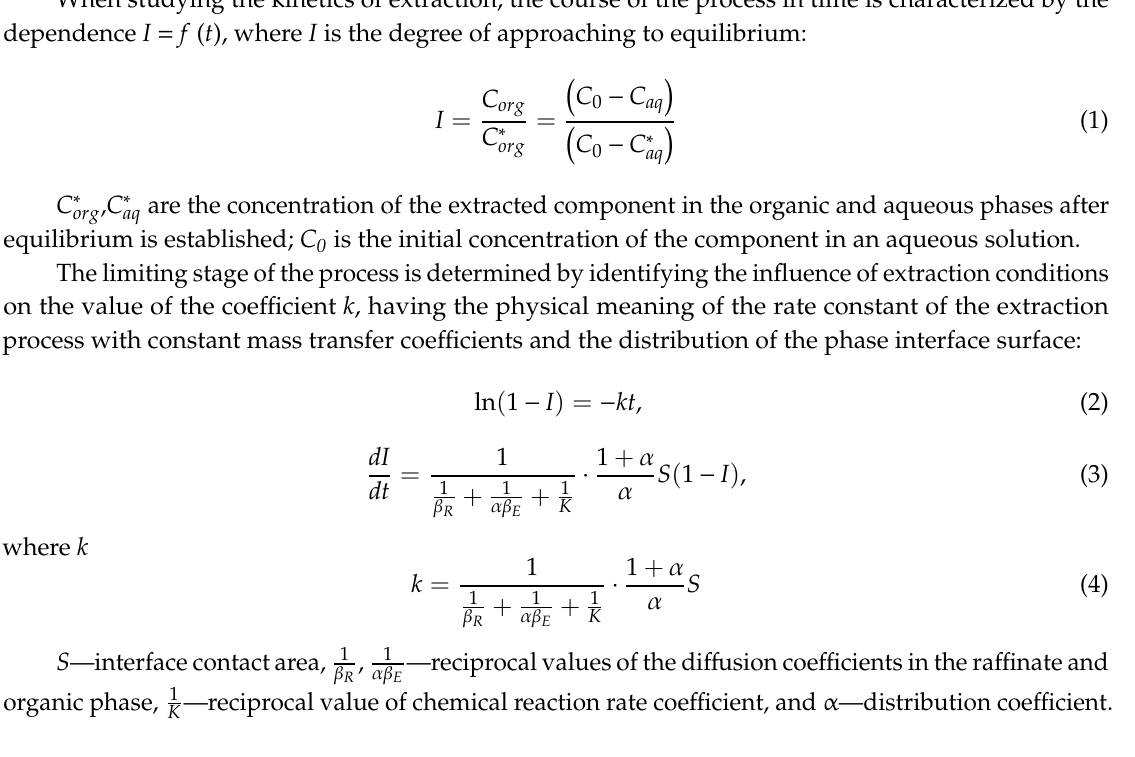
Figure 2. The dependences of the yttrium extraction degree on the phase contact time at different temperatures.